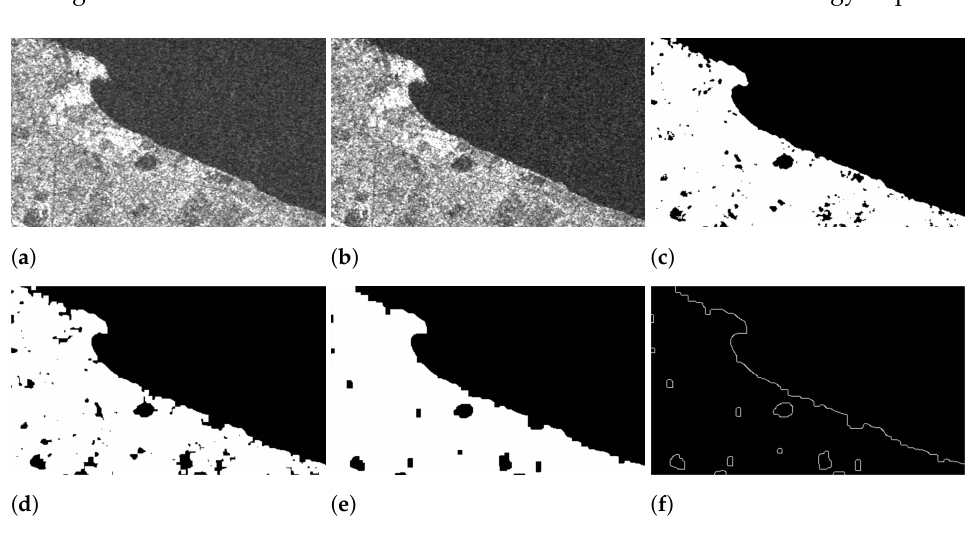
Figure 5. Example of automatic shoreline extraction by Sentinel-1 Synthetic Aperture Radar image. ( a ) original S1 image; ( b ) denoised image; ( c ) binary image; ( d ) image resulting by the opening